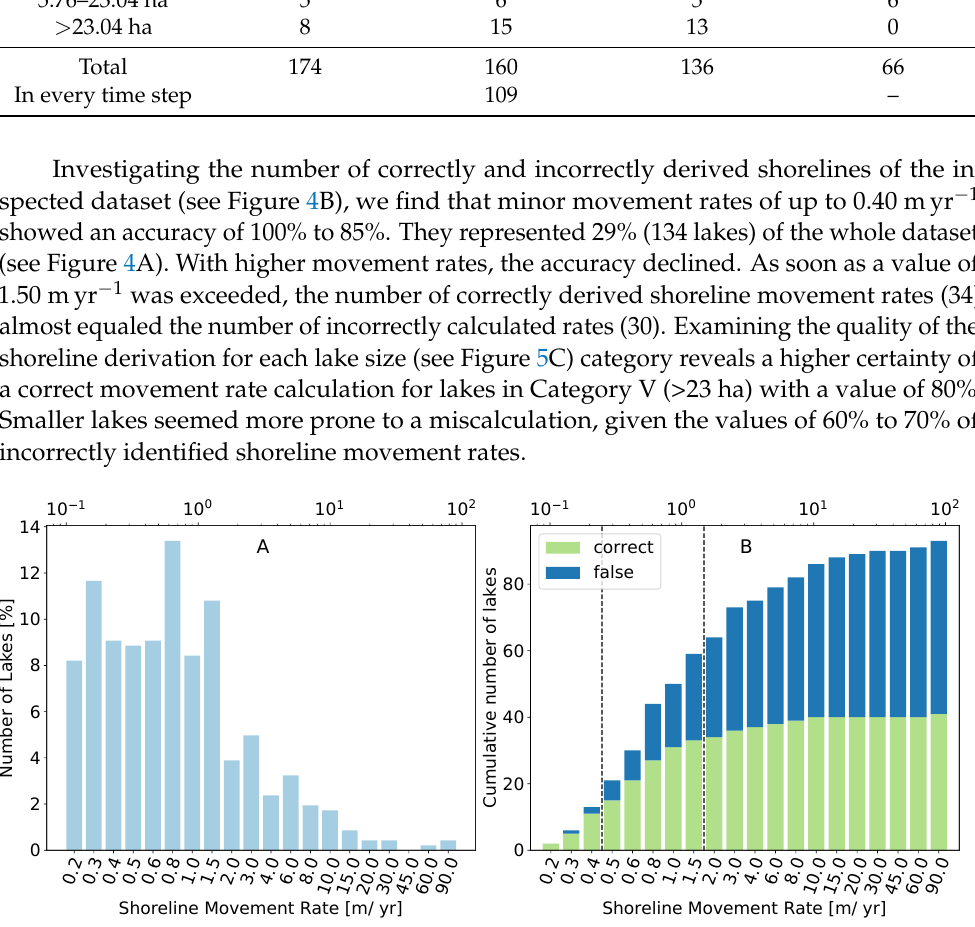
Figure 4. Histogram of all 470 lakes (in percent) at the Deadhorse study site ( A ) for each mean annual shoreline movement rate and corresponding ( B ) number of correctly (green) and falsely (blue) derived shorelines of the inspected sub-sample dataset. Please note that the logarithmic scale (labeled at the top of the x-axis) is divided into seven sub-classes (labeled at the bottom of the x-axis). The median rate of shoreline movement for lakes sized 0.10–0.36 ha was 0.56 m yr − 1 (see Figure 5A). For lake size categories II to IV (0.36–23.04 ha), this ranged from a value of 0.40 to 0.54 m yr − 1 . Lakes larger than 23 ha showed a median movement rate of 1.64 m yr − 1 . The distributions of the correctly derived shoreline movement rates for